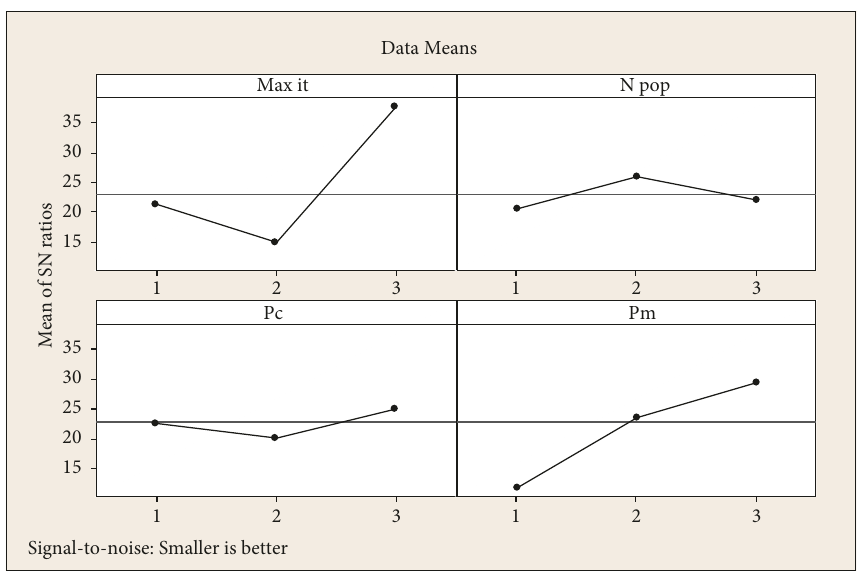
Figure 4: Mean diagram of S/N ratio in NSGA II